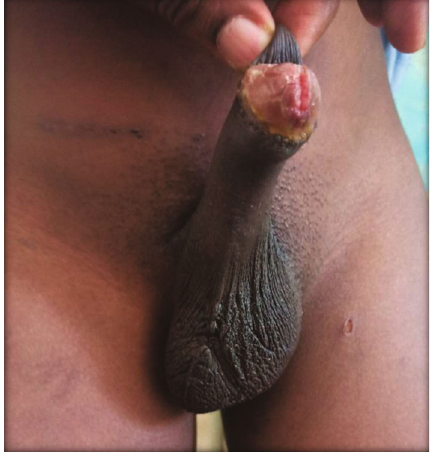
Figure 9: Scrotal aspect on day 5